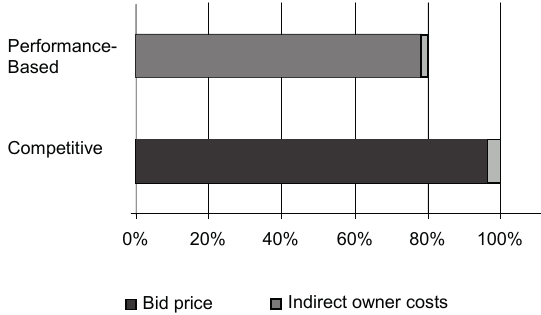
Figure 1. Average overall owner